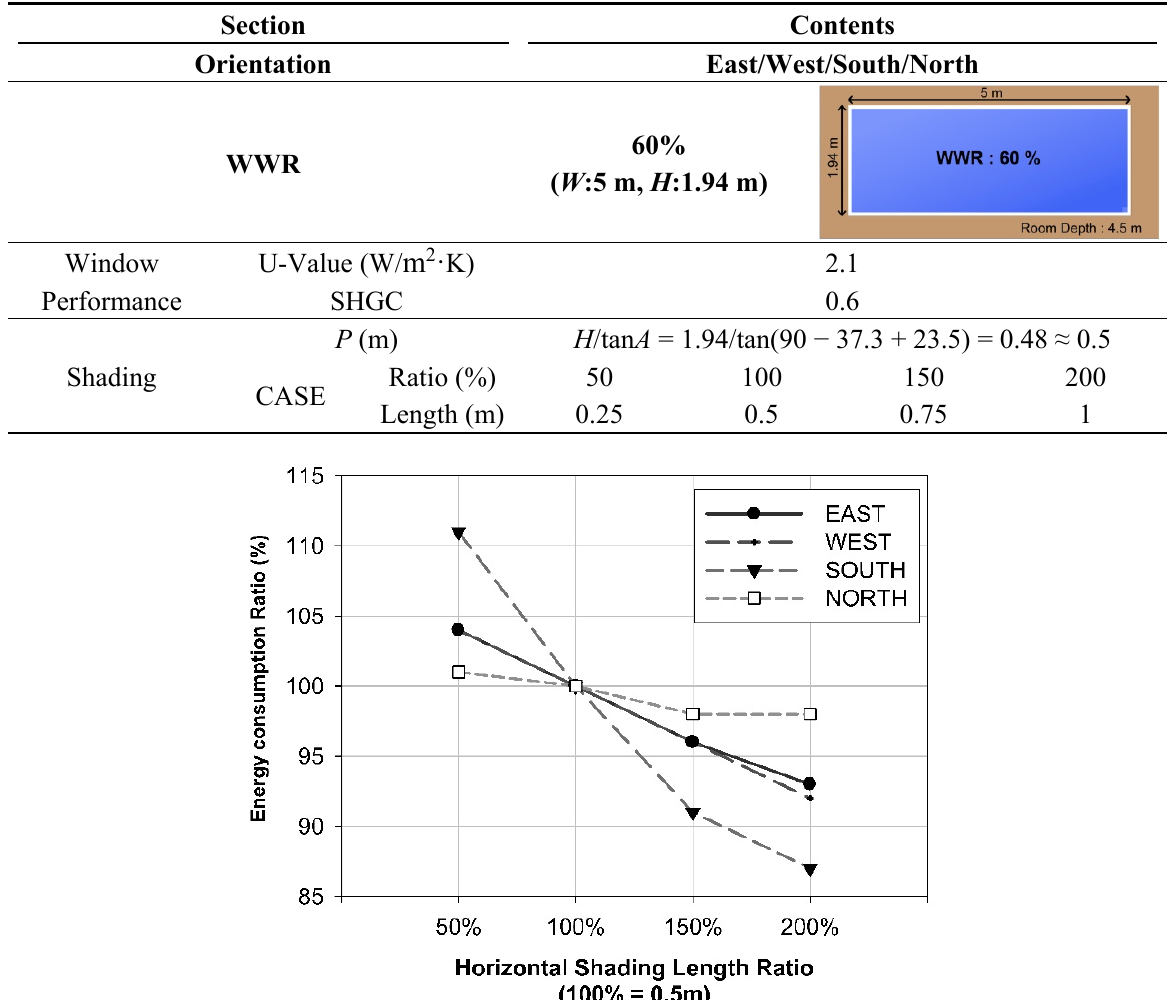
Table 4. Simulation parameter and case.